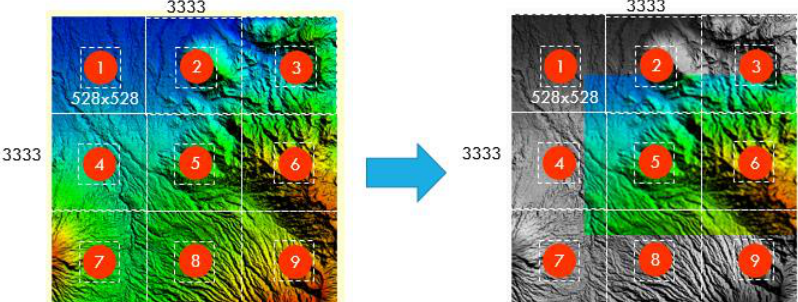
Figure 4. Clipping Attack.